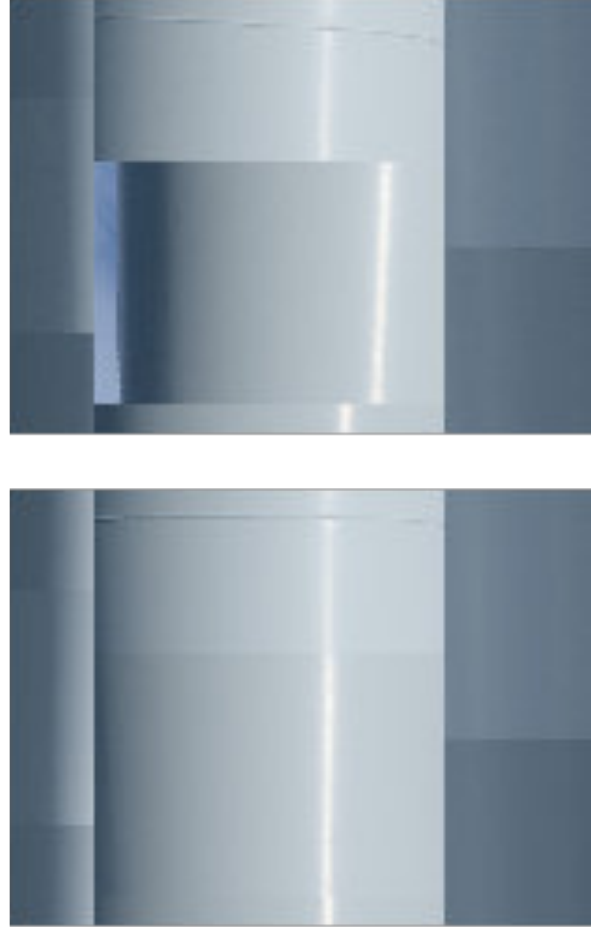
Figure 5. A comparison of a texture detail without (top) and a texture detail with (bottom) correction of the yaw and roll angles. The upper texture clearly shows an artifact (background) that is compensated in the texture at the bottom.